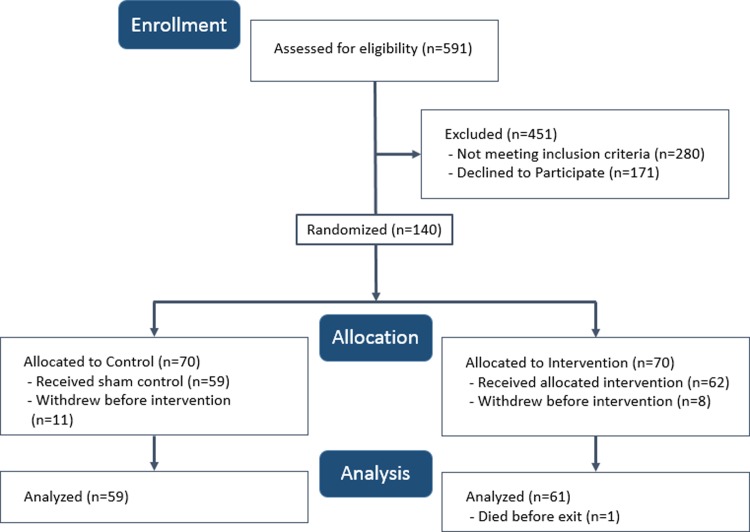
CONSORT diagram describing patient flow through the study.